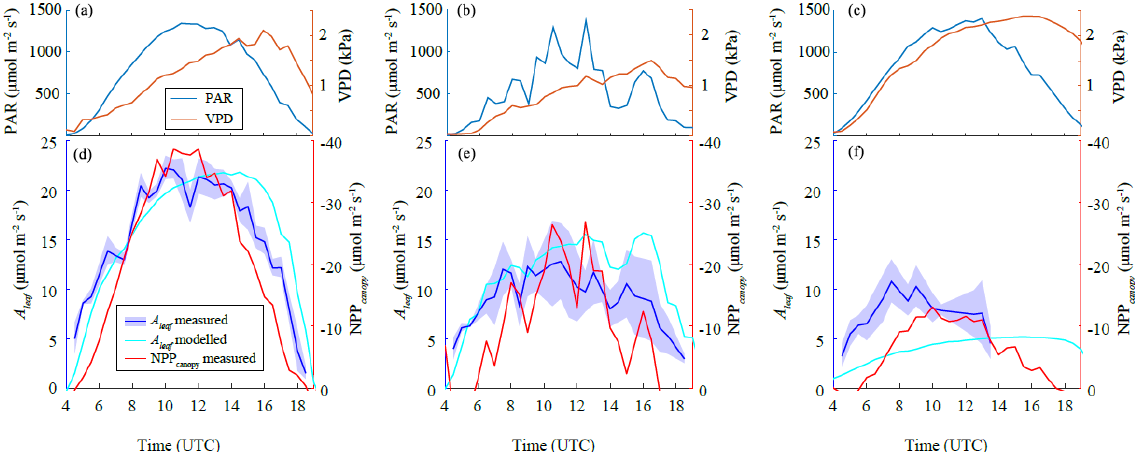
Figure 6. Measured leaf-level photosynthesis ( A leaf ) compared to modelled A leaf using the A - g s model and canopy-level net primary productivity (NPP canopy ) for (a) IOP 1, (b) IOP 2, and (c) IOP 3. Measurements of A leaf were plotted as 30min averages (blue line) and their 1SD confidence interval (shaded region). Panels (d) , (e) , and (f) show diurnal changes in photosynthetically active radiation (PAR) and vapour pressure deficit (VPD) measured for each